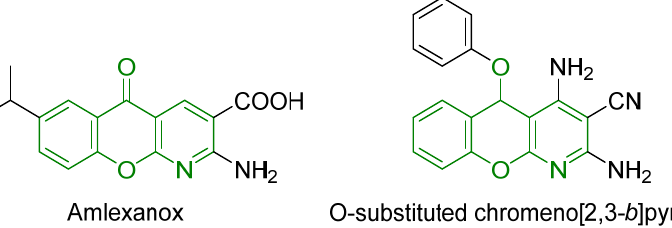
Figure 1. 5- O -chromeno[2,3- b ]pyridines with proven useful